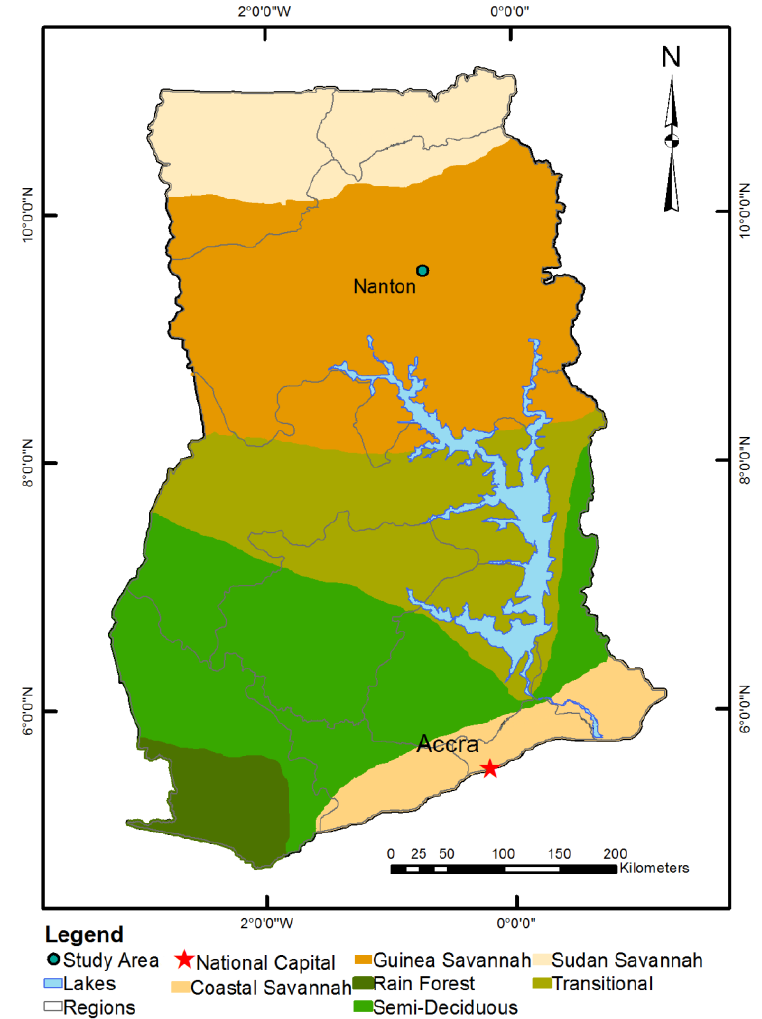
Figure 4. Location of the study area in Ghana.